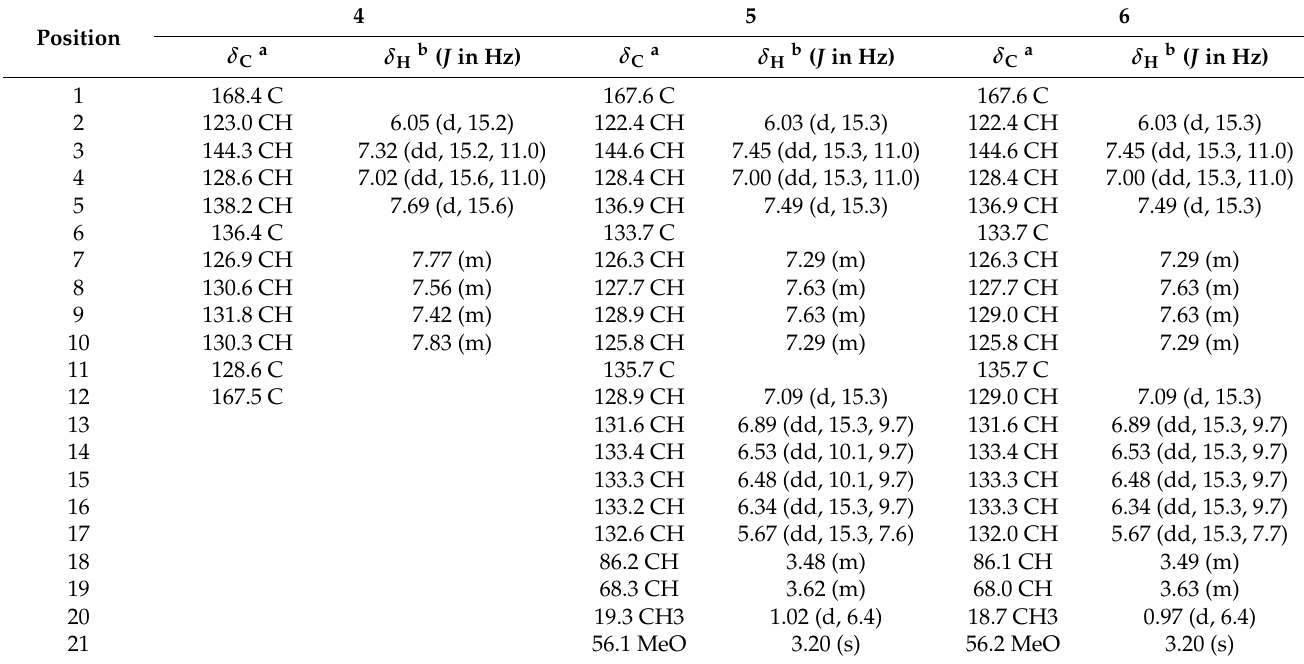
Table 2. NMR data for 4 –